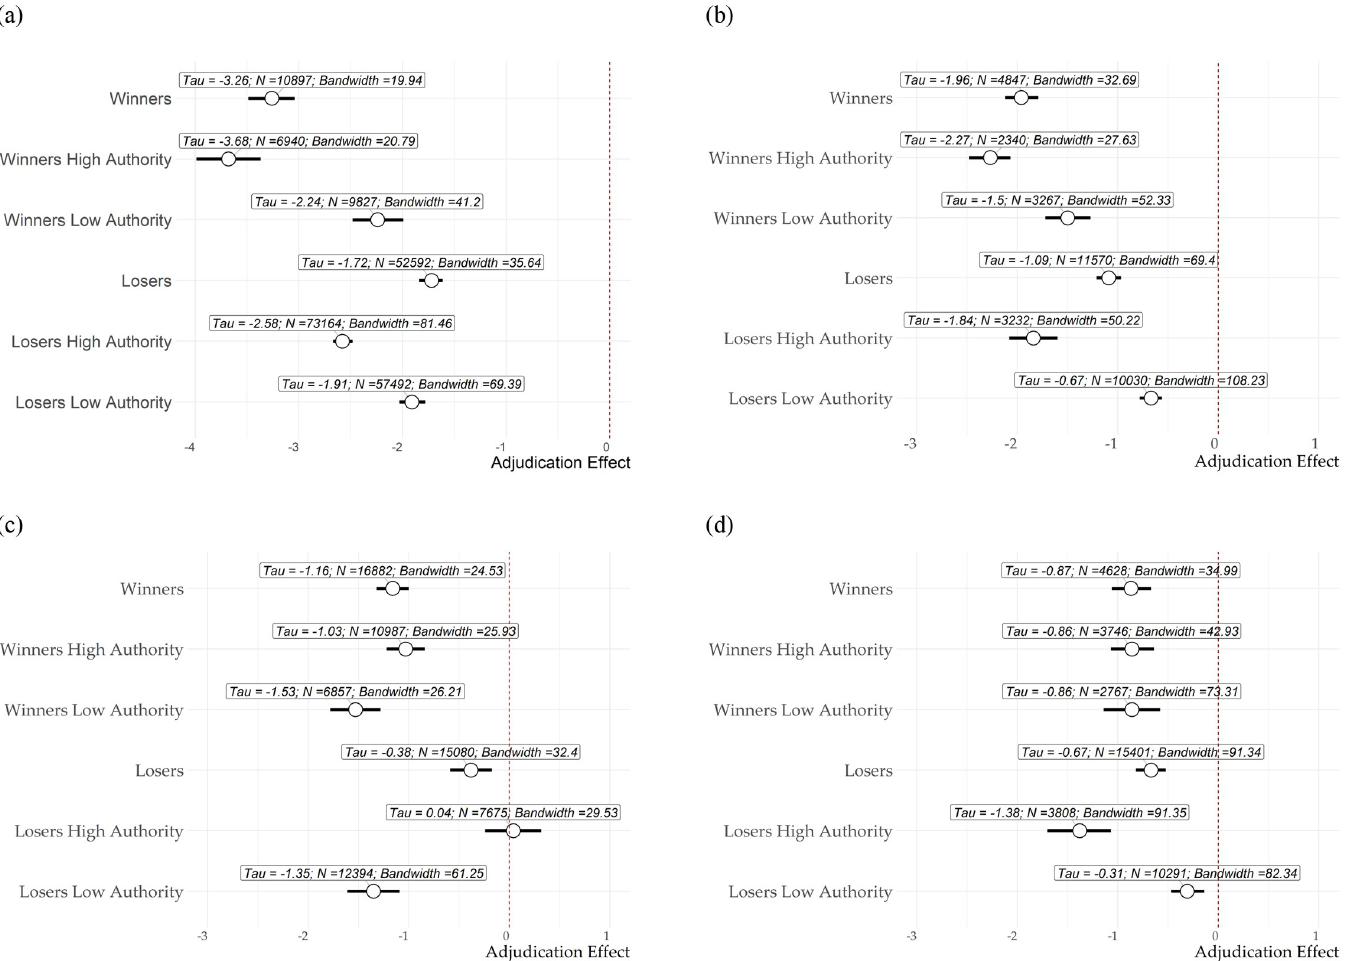
Fig 6. Adjudication effect. Results at cutoff estimated with local linear regression with triangular kernel and MSE-optimal bandwidth. The figure reports 95% robust confidence intervals for the point estimates [32]. (a) UK Election, (b) Argentina Election, (c) Brazil Election, (d) US Election.